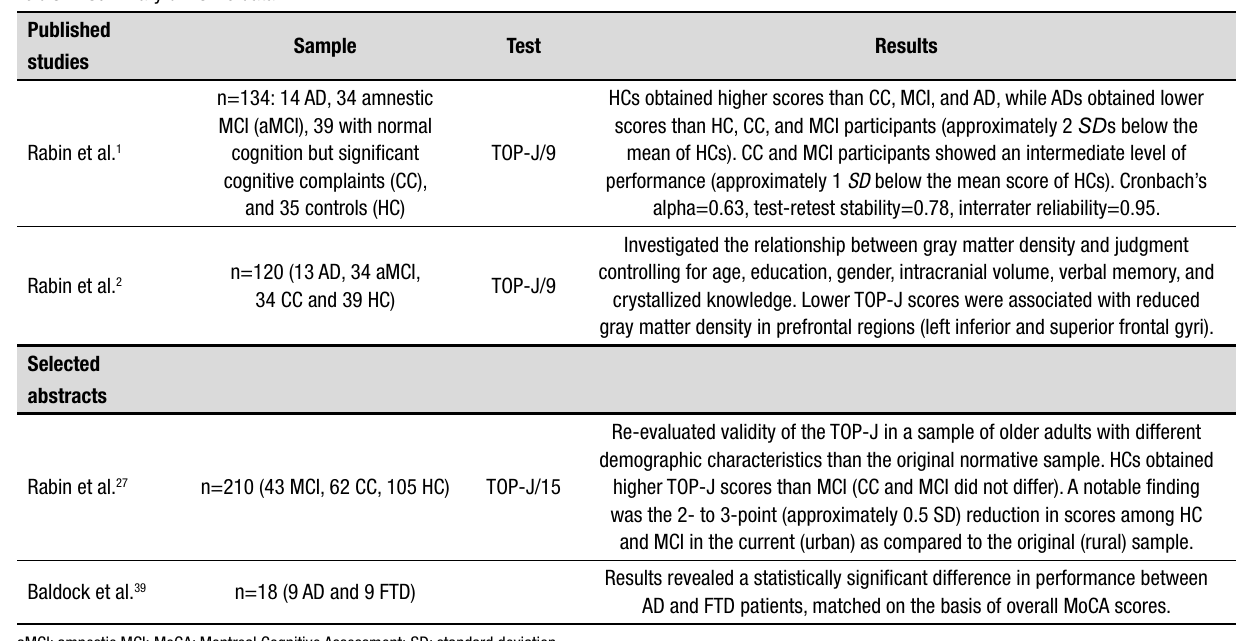
Table 1. Summary of TOP-J